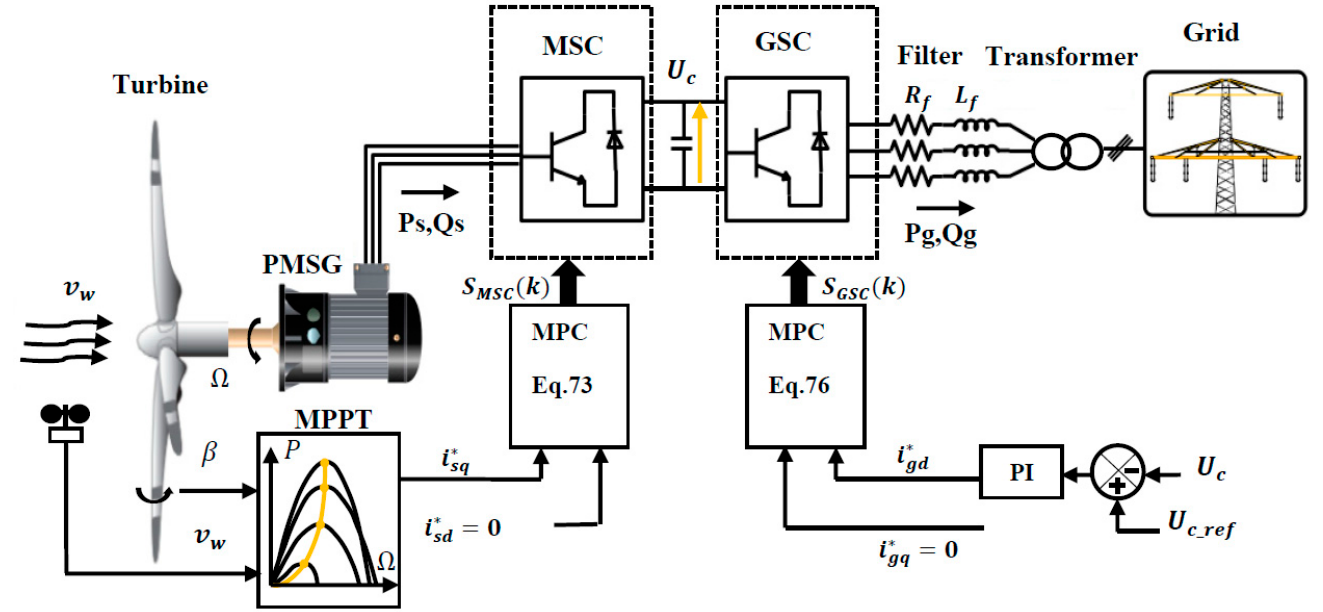
Figure 14. Synoptic schema of MPC applied to the PMSG-wind energy conversion system.